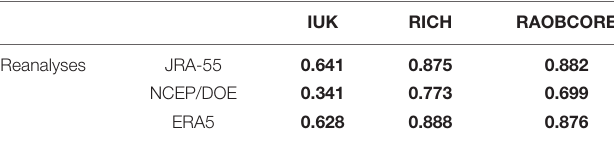
TABLE 3 | Correlation coefficients of TTI between radiosonde and the reanalysis data (bold indicates a correlation coefficient above 0.32, representing the significance test at the 95% confidence